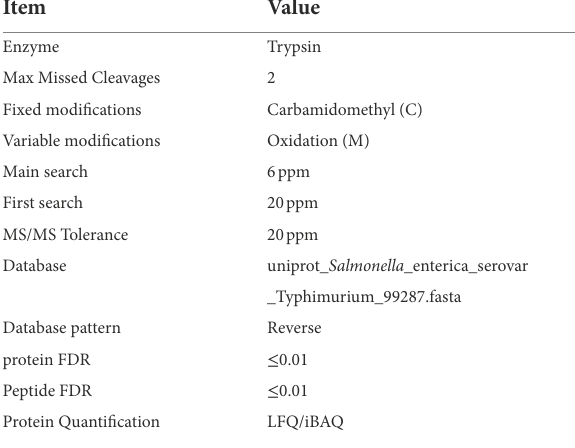
TABLE 1 Parameters and instructions for identification and quantitation of